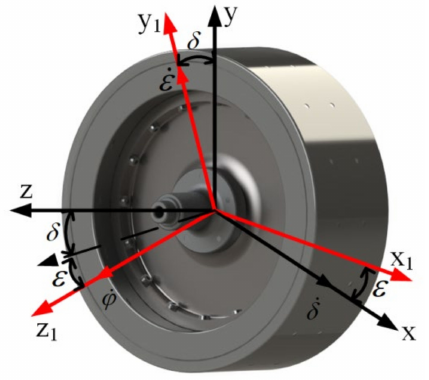
Figure 1. System principle and reference